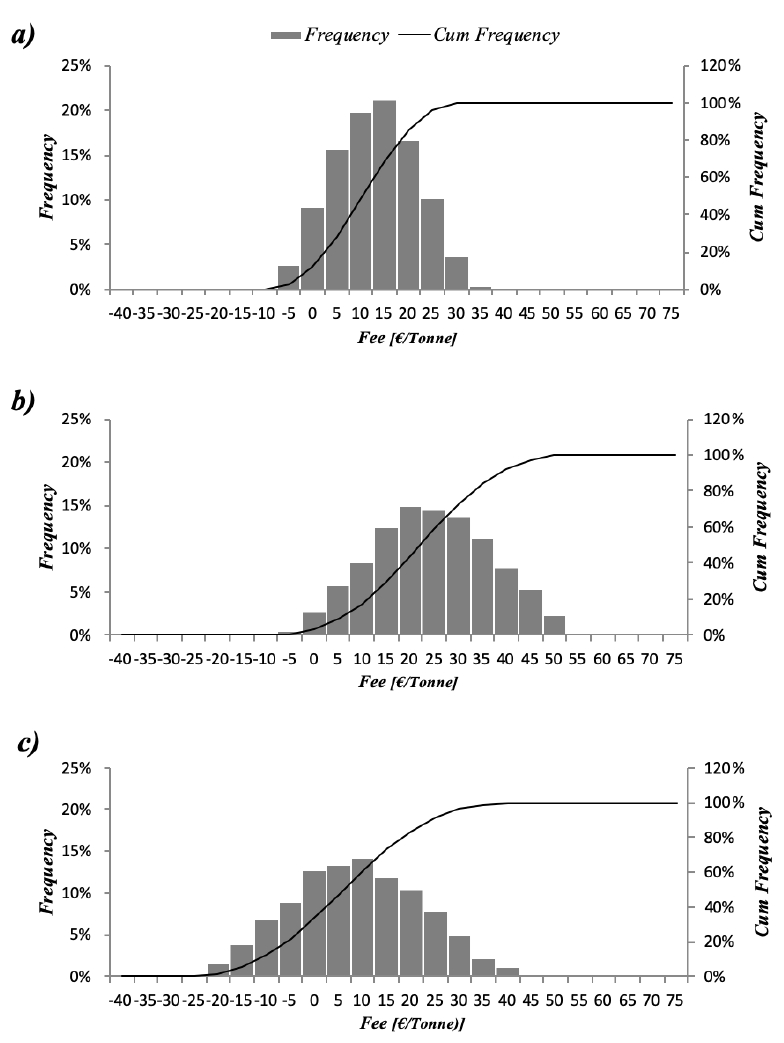
Figure 1. Fee density and distribution function. ( a ) Scenario 1, Composting; ( b ) Scenario 2, renewable electricity production; ( c ) Scenario 3, biomethane